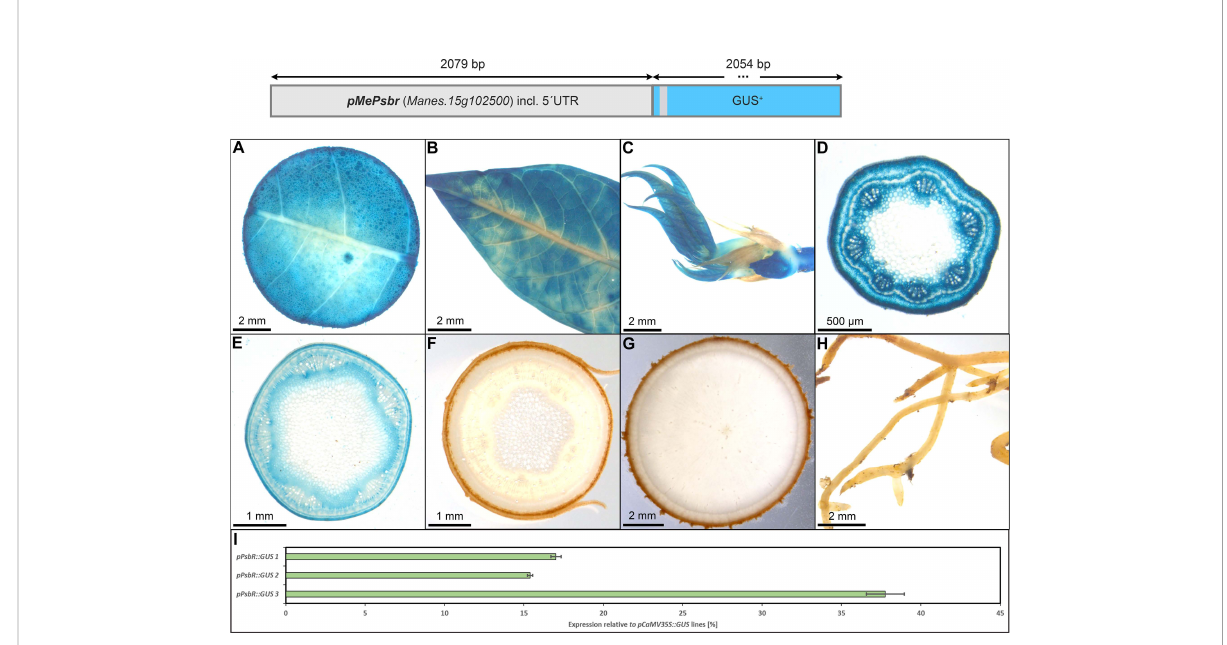
FIGURE 3 Representative GUS staining pattern of three pMePsbr::GUS promoter-reporter lines. (A) Source leaf, (B) Sink leaf, (C) Emerging leaves, (D) Petiole cross-section, (E) Upper stem cross-section, (F) Lower stem cross-section, (G) Storage root cross-section, (H) Fibrous roots, (I) GUS expression levels of three pPsbR::GUS lines relative to three pCaMV35S::GUS lines in %. Bars represent mean values with standard deviation